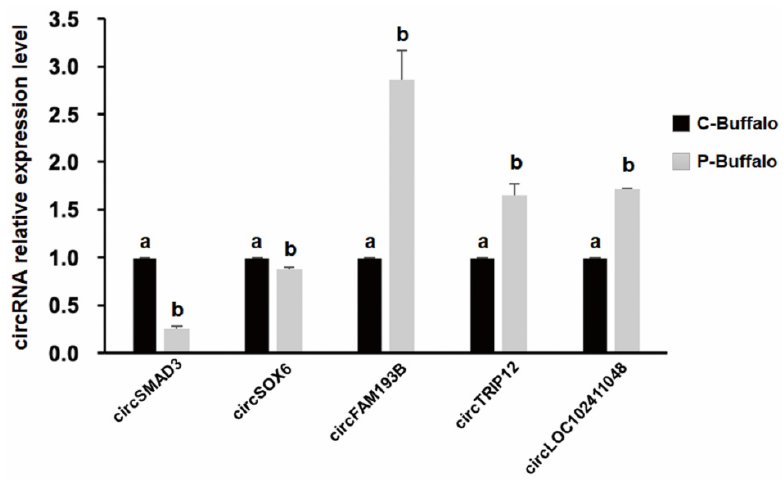
Figure 6. Validation of the selected DECs identified between P-Buffalo and C-Buffalo. The selected circRNAs were chosen from the DECs of venous blood of C-Buffalo and P-Buffalo. The relative abundance of circRNAs C-Buffalo and P-Buffalo was quantified by qPCR. Normalization of the data with the endogenous housekeeping gene GAPDH was performed, and the number of values for C-Buffalo was set to 1. Different letters on the bars indicate significant differences ( p < 0.05). Data are presented as mean ± S.E.M. Statistical analysis was done by t-student test.